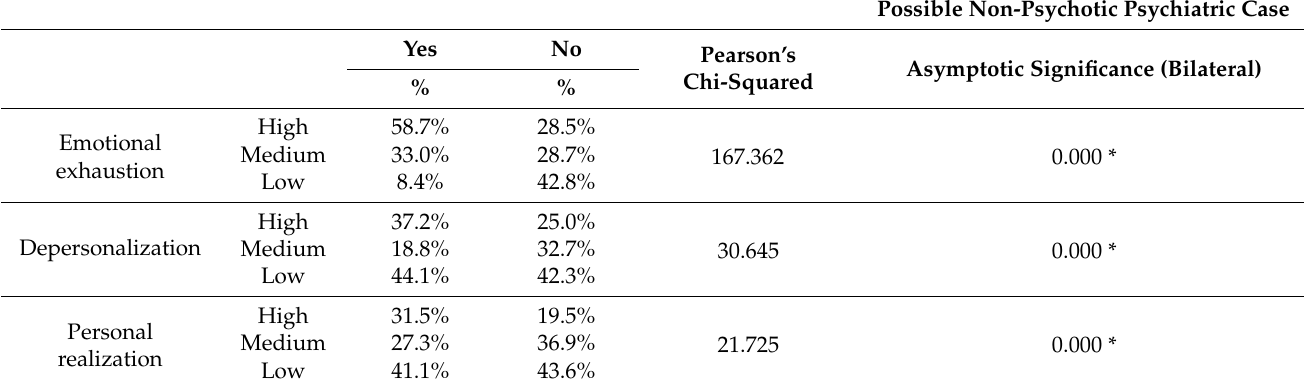
Table 3. Group statistics and Pearson’s Chi-squared test for the variables of emotional exhaustion, depersonalization, and personal realization a . Possible Non-Psychotic Psychiatric Case